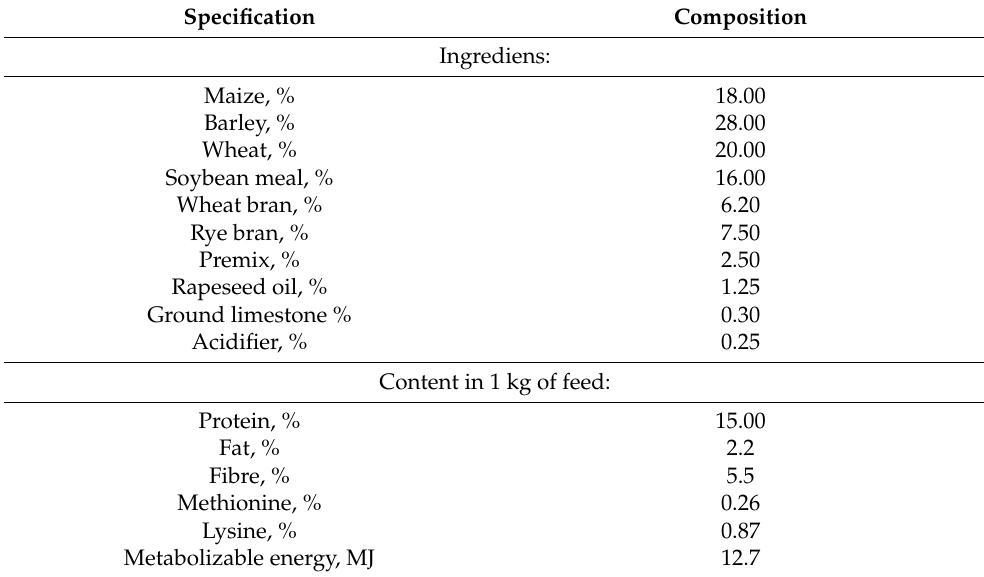
Table 1. Composition and nutritional value of the feed mixture.